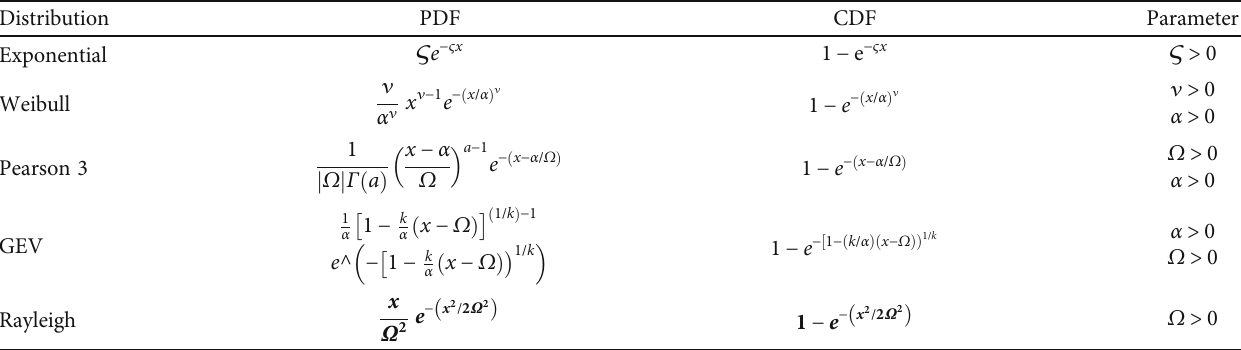
Table 2: Details of compared probability